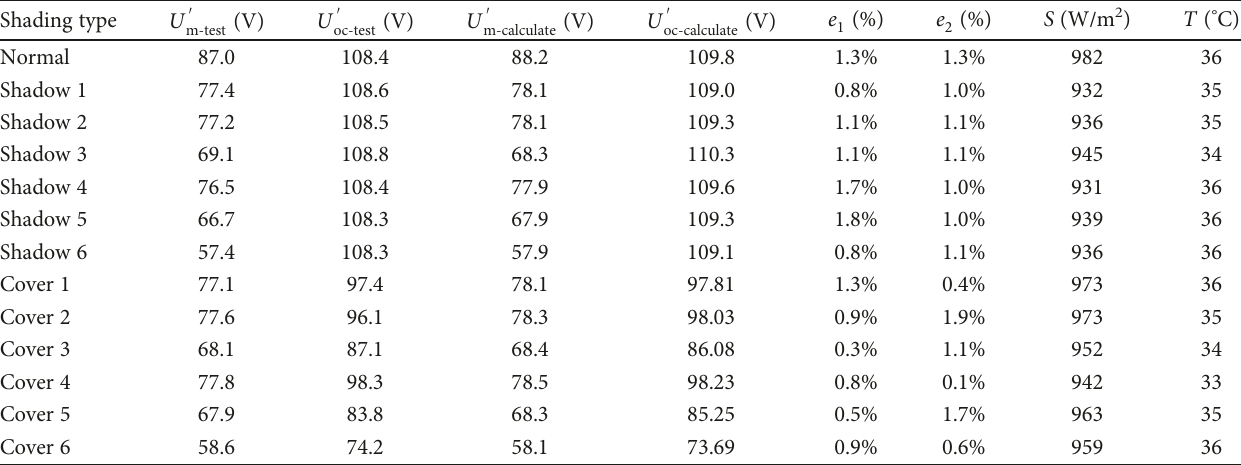
Table 5: Error analysis for computation